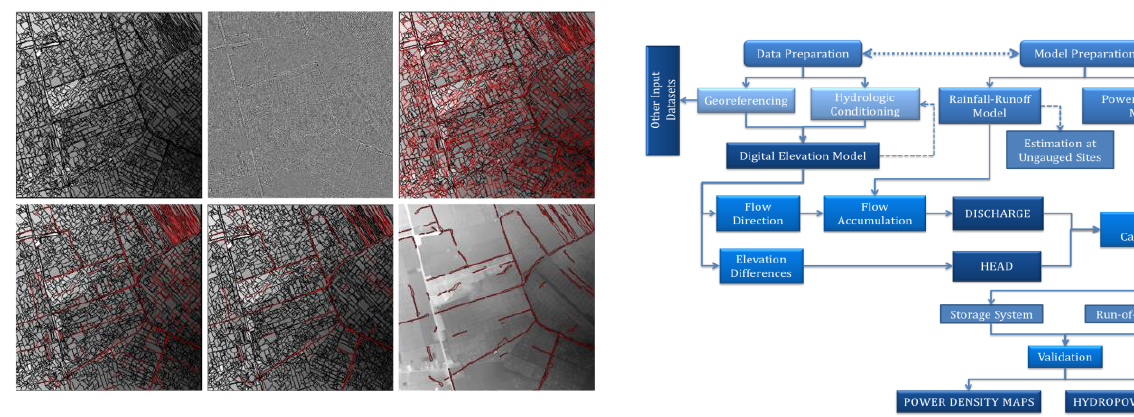
Figure 12. Workflow for hydropower resource assessment using LiDAR